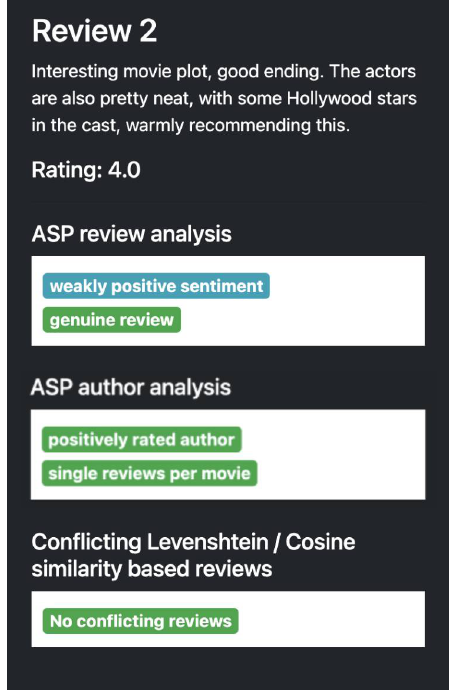
Figure 4. Genuine review example.